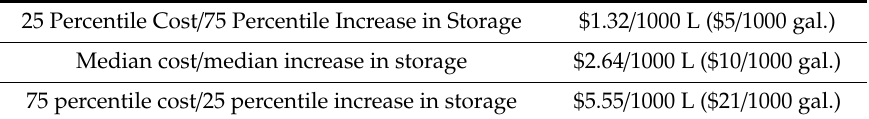
Table 8. Cost in US dollars for Plug and Pond Method meadow restoration per 1000 liter (1000 gallons). Adapted from American Rivers, 2012